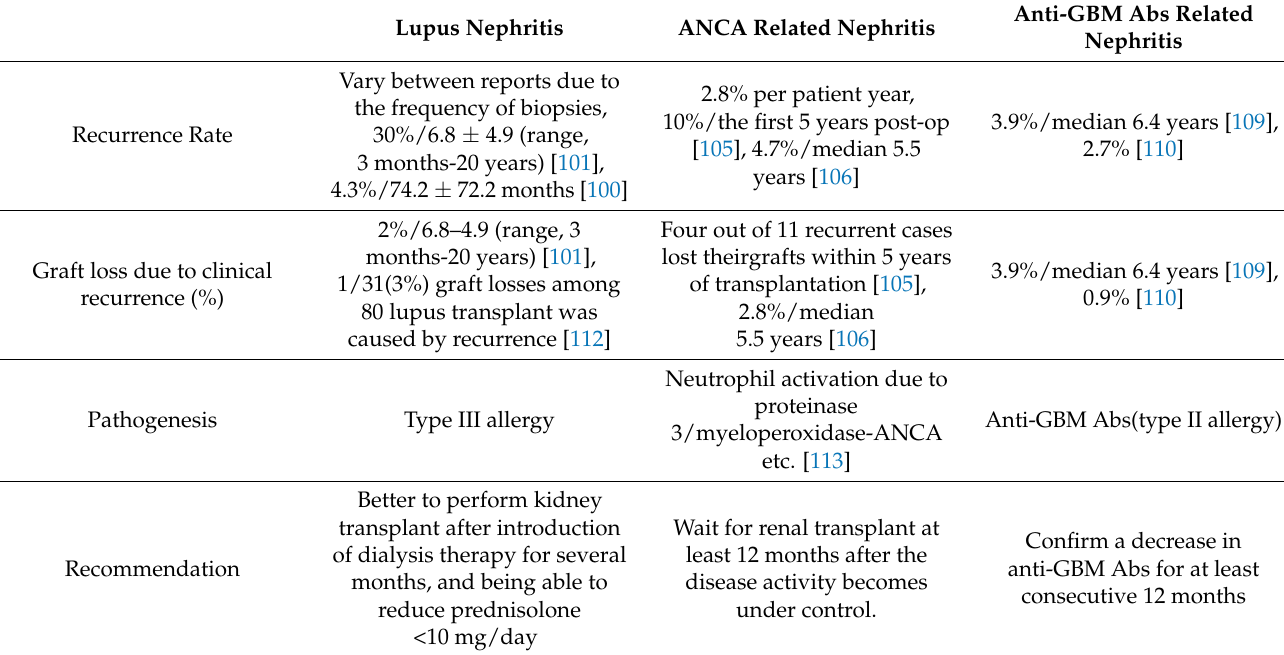
Table 3. Summary of recurrence rate and graft survival in patients with recurrence in lupus/ANCA/anti-GBM nephritis following kidney